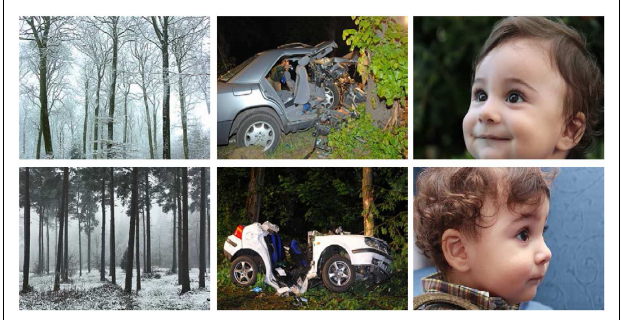
FIGURE 1 |Three exemplary pairs of used target and distracter pictures illustrating the range of emotional intensity and valence covered by the stimuli as well as target – distracter similarity